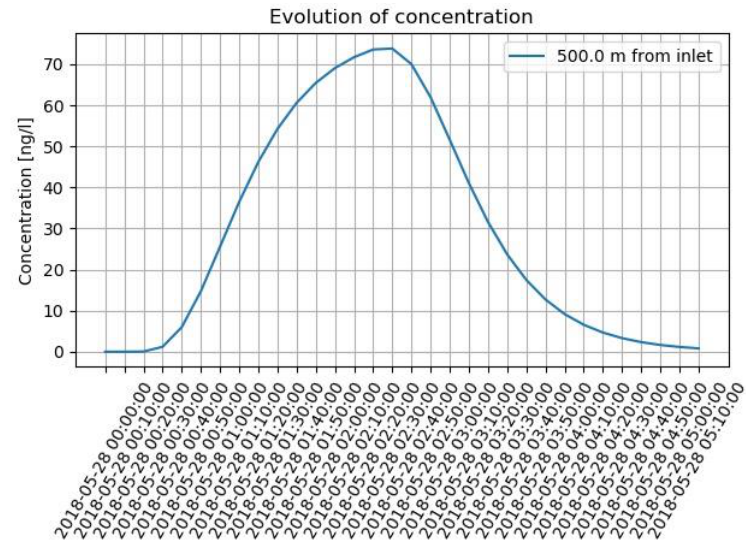
Figure 9. Time-limited pulse C 0 mass injection: concentration values at 500 m from the inlet. Table 2. Data used in the test presented in Section 3.2.3.